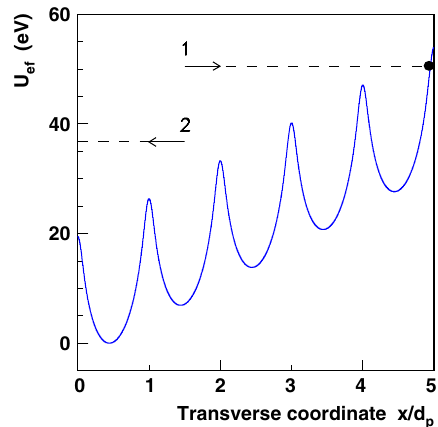
Fig. 1 Transversecrossingofparticles1and2intheeffectivepotential U ef ofasiliconcrystalbentalongthe(110)planes,reportedasafunction of the planar channel width d p , equal to 1.92 Å. Particle 1 moves to the inner side and reaches the reflection point in the effective potential (shown by a closed circle), where the particle changes its transverse direction, that is volume reflection occurs. Particle 2 moves to the side